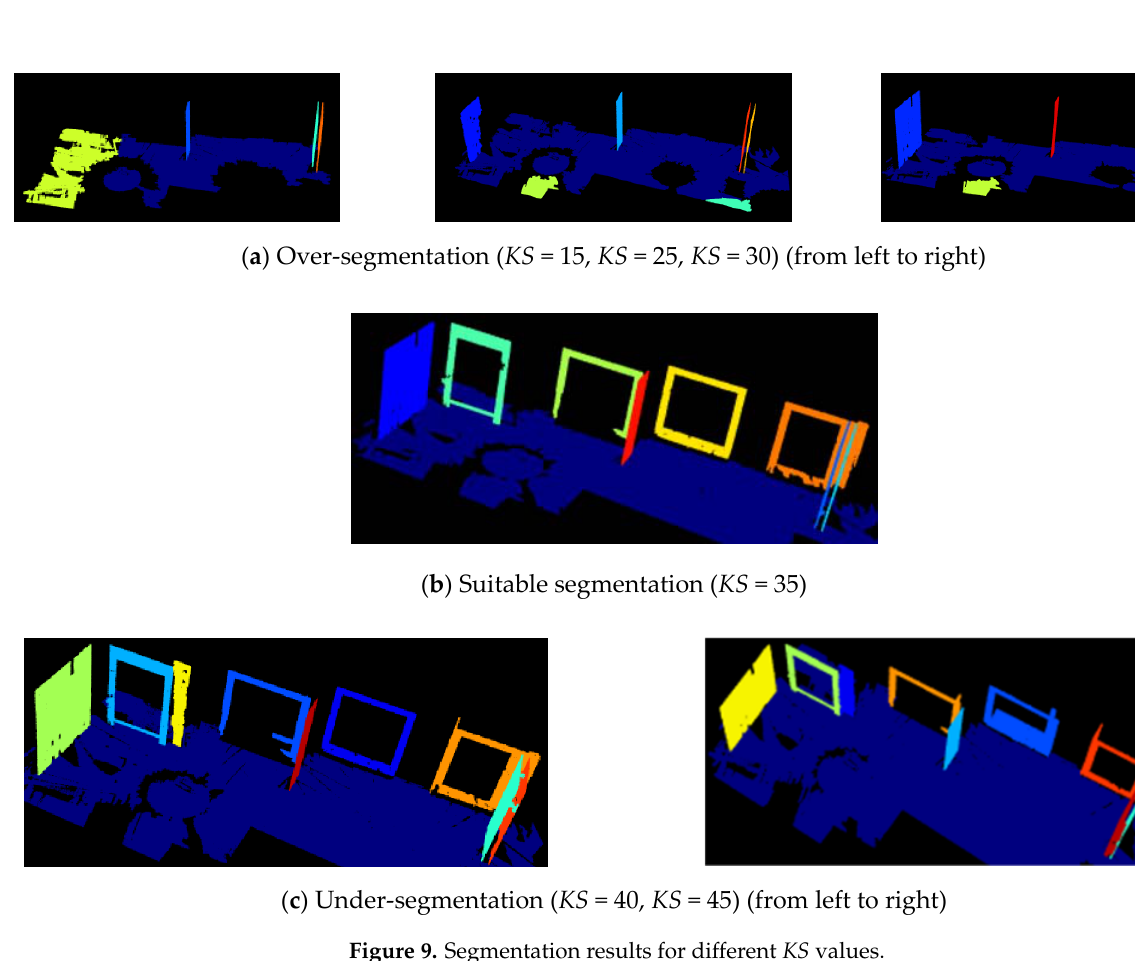
Figure 9. Segmentation results for different KS values.